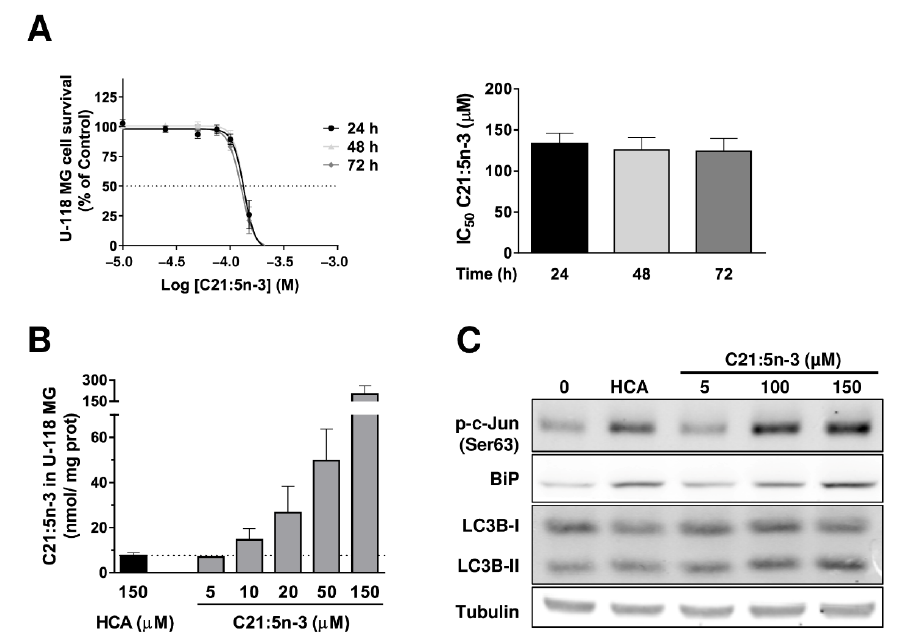
Figure 6. Study of the C21:5n-3 metabolite in U-118 MG cells. ( A ) Time- and concentration-depend- ent inhibition of U-118 MG cell growth by C21:5n-3 (left) and IC 50 values for C21:5n-3 against U-118 cells’ proliferation after 24, 48, and 72 h treatments (mean ± SEM from 3 independent experiments performed in quadruplets, right). ( B ) Comparison of the amount of C21:5n-3 in cells treated for 48 h with C21:5n-3 (5, 10, 20, 50, and 150 µM) or HCA (150 µM) and analyzed by GC (the bars corre-